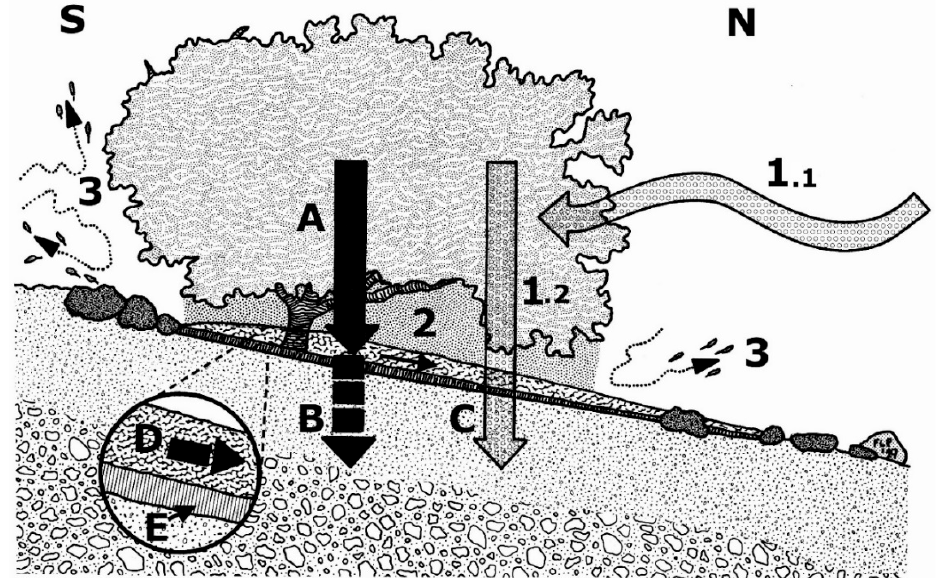
Figure 12. Conceptual model depicting main influences of k ū paoa on pedogenesis under, and downslope of, shrubs. Plant outline drawn from photographs, shown on an ~11° slope, oriented along a south (left) to north (right) axis. Letters refer to biological or geomorphic interactions, numerals to microclimatic effects. Key . A : Most prominent factors are litterfall (solid black arrow), leading to the buildup of litter islands, and B : Downward transfer of soil organic matter through soil profile (dashed black arrow); C : Increased water input and infiltration through soil under canopy, due to higher SOM content; D (round inset): Black arrow shows downhill displacement of litter horizon due to slope creep movement; E (round inset): Thin stable soil crust , immediately below litter horizon, with high shear strength and resistance to erosion. 1.1: Fog interception of air masses brought by NE trade winds, which causes 1.2 : Fog-drip addition of water to soil beneath plant crown; 2: Diurnal canopy shading and nightly heat reradiation of ground below shrub; 3: Dense canopy growth near the ground surface offers protection against litter erosion by wind . Consult text for additional explanations.